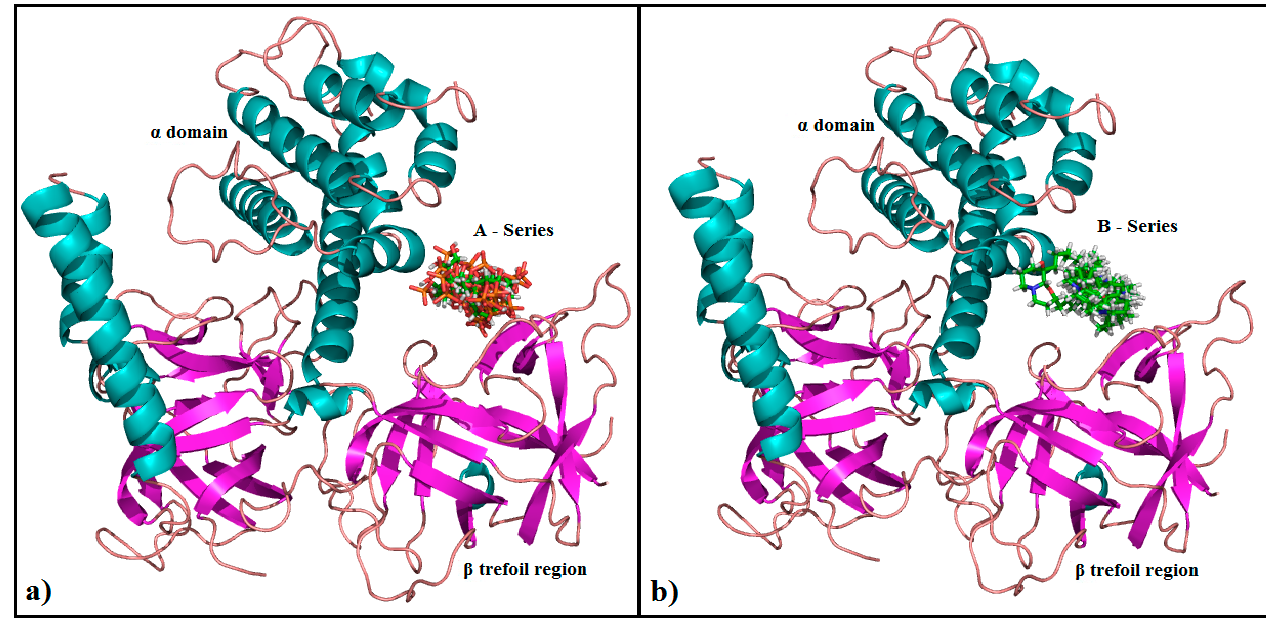
Figure 3. IP 3 R binding core showing α domain in cyan and β trefoil region in magentas. ( a ). The orientation of docking solutions of compounds in class ‘A’, clustered in the binding pocket of IP 3 R. ( b ). The orientation of docking solutions of compounds in class ‘B’, clustered in the binding pocket of IP 3 R.